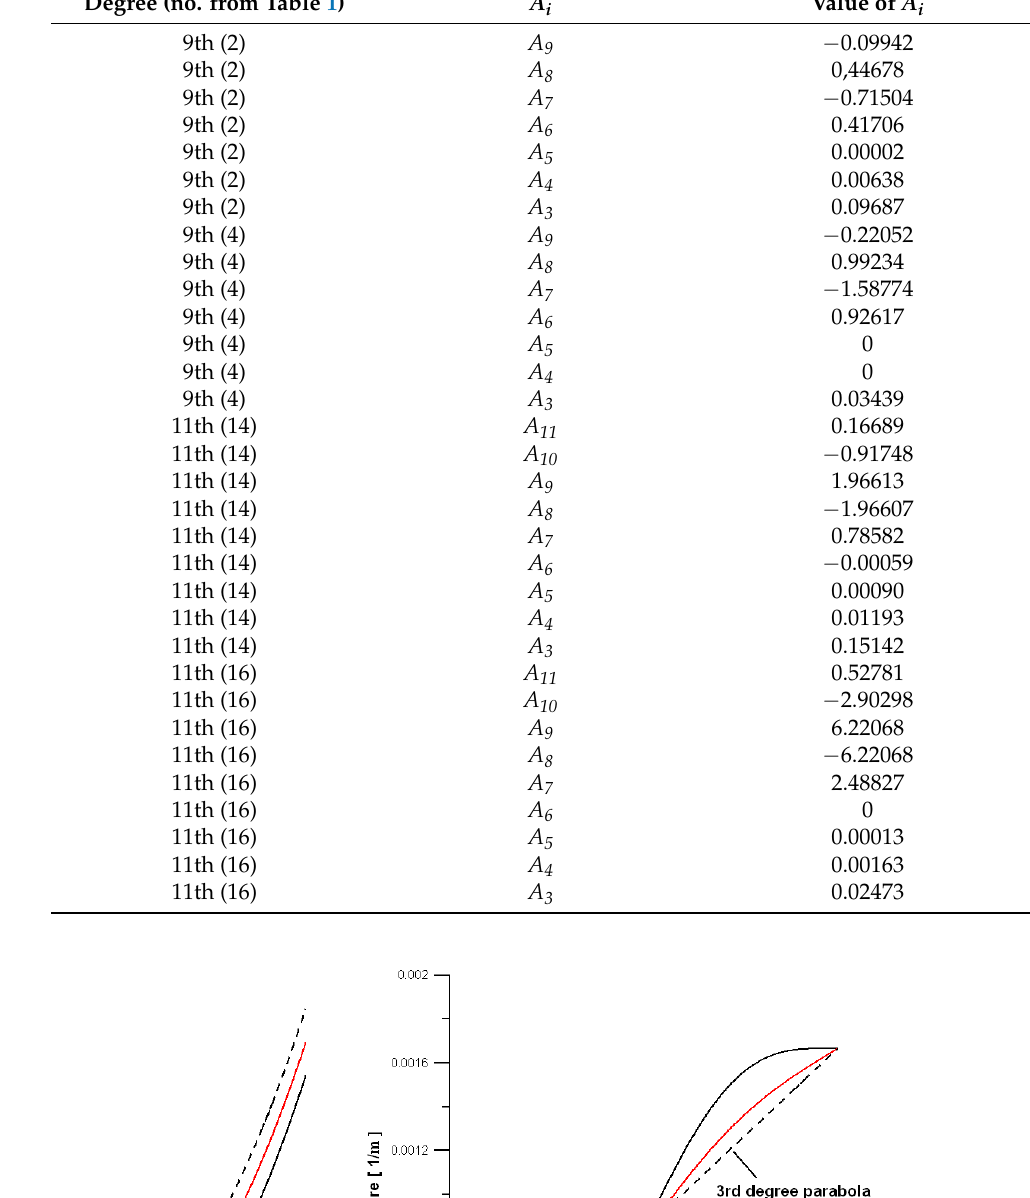
Table 3. Optimum polynomial coefficients.